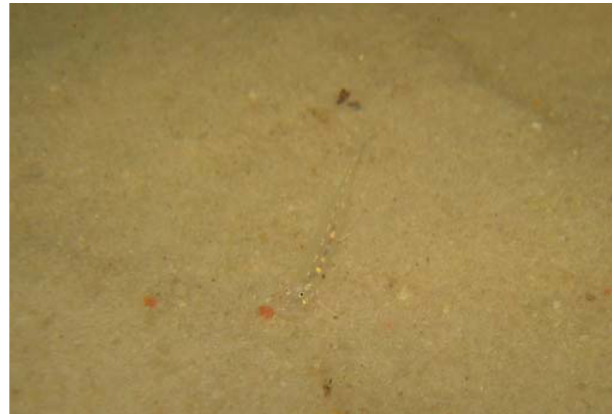
Fig. 4 . The minute and translucent Stauroglanis gouldingi (not preserved) poised on the sandy stream bottom.